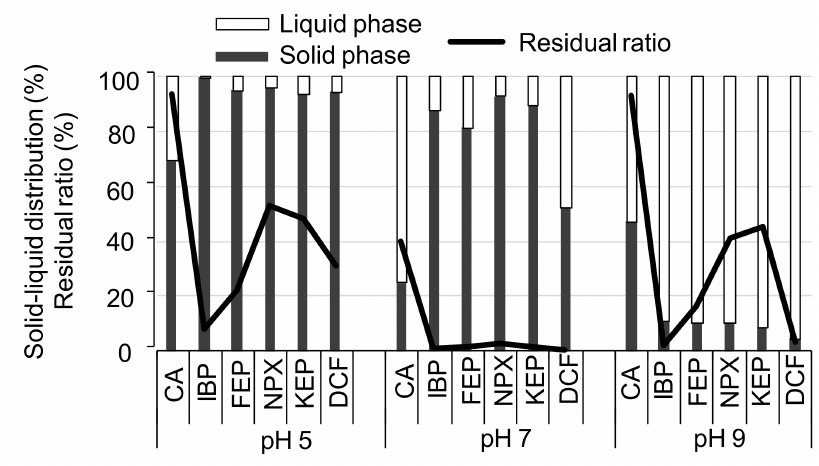
Figure 6. E ff ect of pH on the residual ratios and solid-liquid distribution of the pharmaceuticals after 14 days of incubation under aerobic